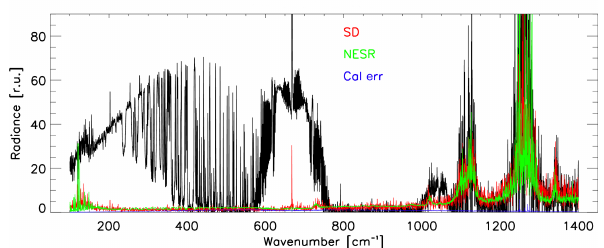
Figure 1. Example of a clear-sky spectrum as seen from REFIR- PAD (in black) and its associated standard deviation (in red), the noise equivalent spectral radiance (in green) and the calibration er- ror (in